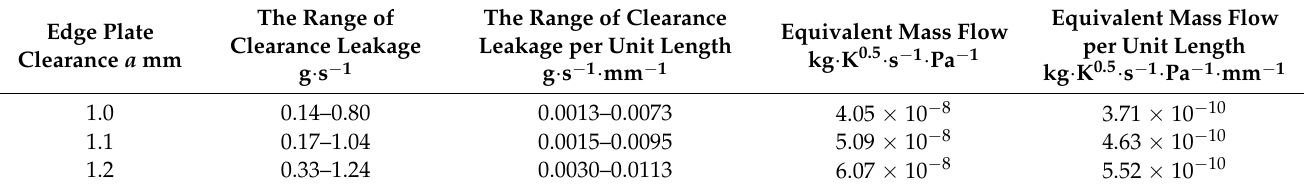
Figure 9. Experiment with different edge plate clearances. ( c = 1 mm). ( a ) Clearance leakage against pressure ratio. ( b ) Equivalent mass flow of clearance leakage against pressure ratio. Table 3. The range of the clearance leakage and the equivalent mass flow of the clearance leakage under different edge plate clearances. ( c = 1 mm).